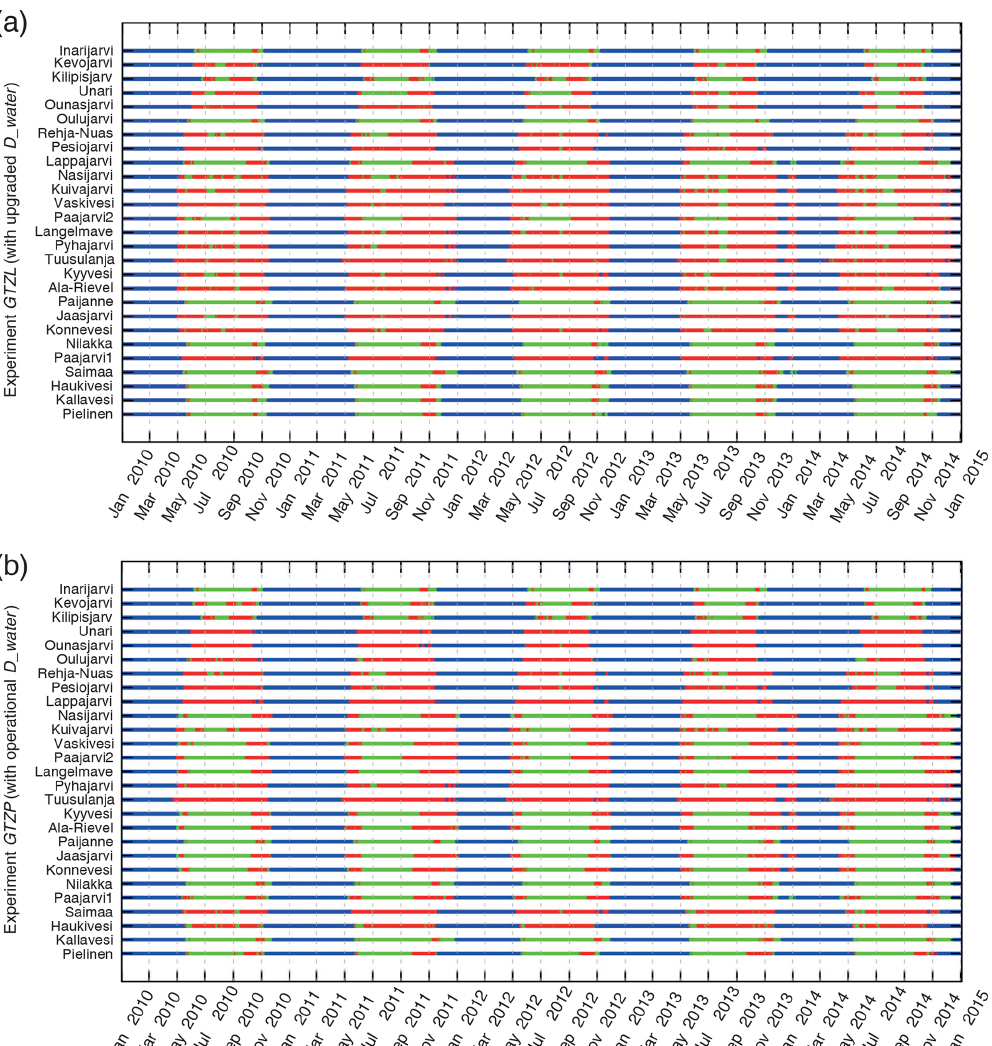
Figure 12. Lake seasons for 2010–2014 for 27 verification sites based on operational (b) and upgraded (a) D water ; blue – lake is ice-covered, red – lake is mixed till the bottom, green – lake is stratified (ice-free and non-mixed, residual